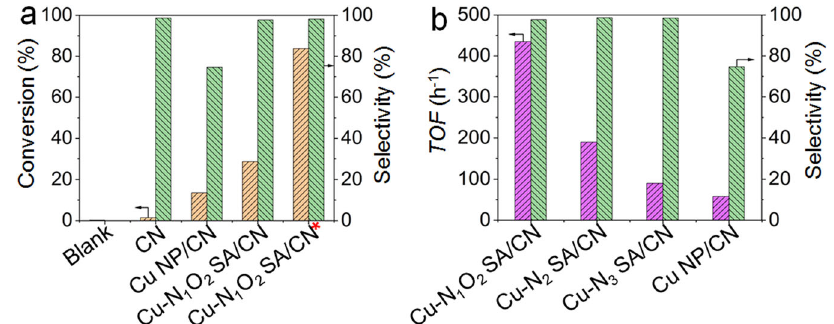
Fig. 4 | Selective oxidation of benzene to phenol with 2:1 of H 2 O 2 /benzene molar ratio. a Catalytic performance over various catalysts for SOBP. Reaction conditions: 30mg catalyst, 0.4mL benzene, 2:1 H 2 O 2 /benzene molar ratio, 2.0mL CH 3 CN as solvent, 60°C, 5h. *50mg catalyst, 72h, other conditions are same as